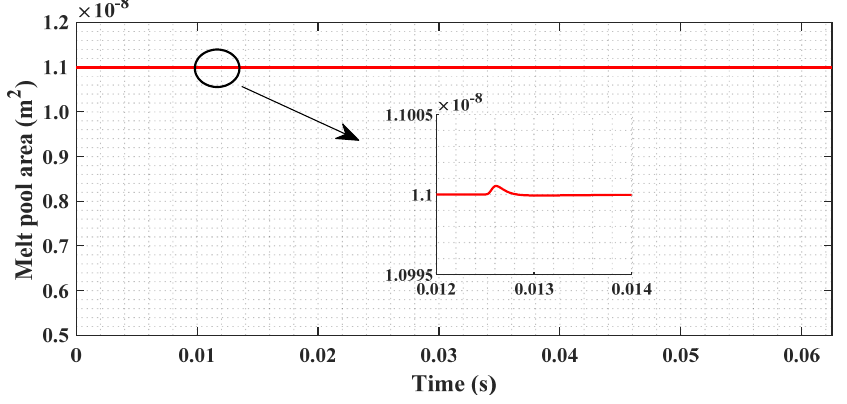
Figure 6. Melt pool area regulation by LADRC.